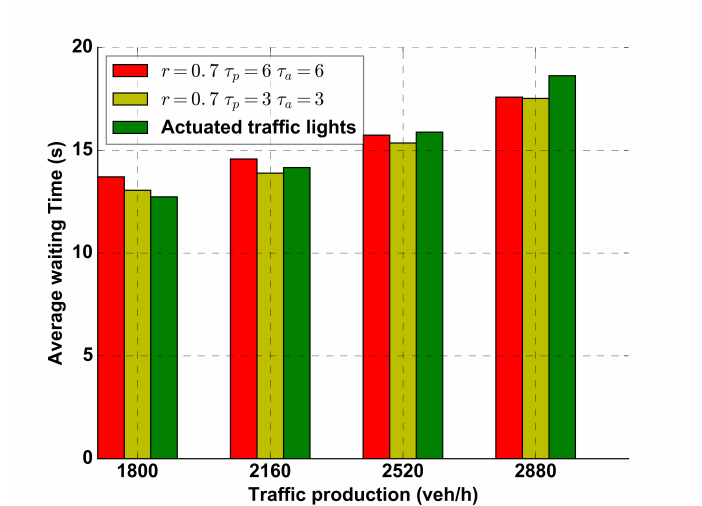
Figure 12. Comparison performance of average waiting time between DDQN with dual-agent and actuated traffic signals under different ratio r and control time